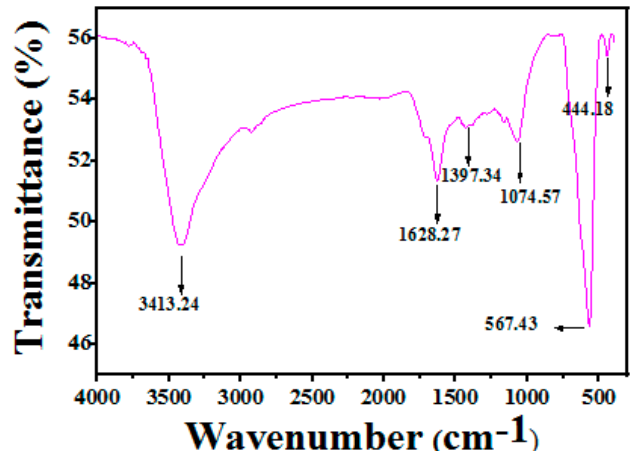
Figure 5. FTIR spectrum of C-Fe 3 O 4 nanoparticles.